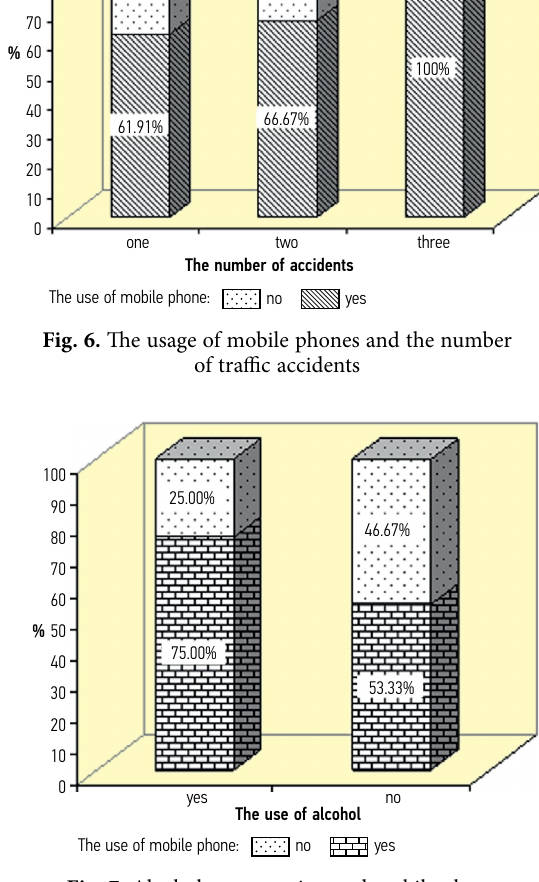
Fig. 7. Alcohol consumption and mobile phones usage while driving